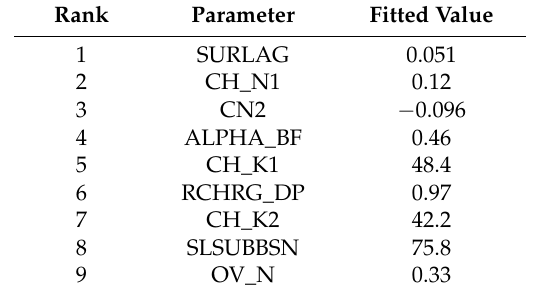
Figure 5. Observed and simulated flowrate (m 3 · s − 1 ) at Lumban Station over the calibration periods, together with the 95% uncertainty band (95 PPU). The flowrate is plotted against the precipitation (mm) for the whole period. Table 5. SWAT parameters for calibration and sensitivity analysis of the original SWAT pesticide model.